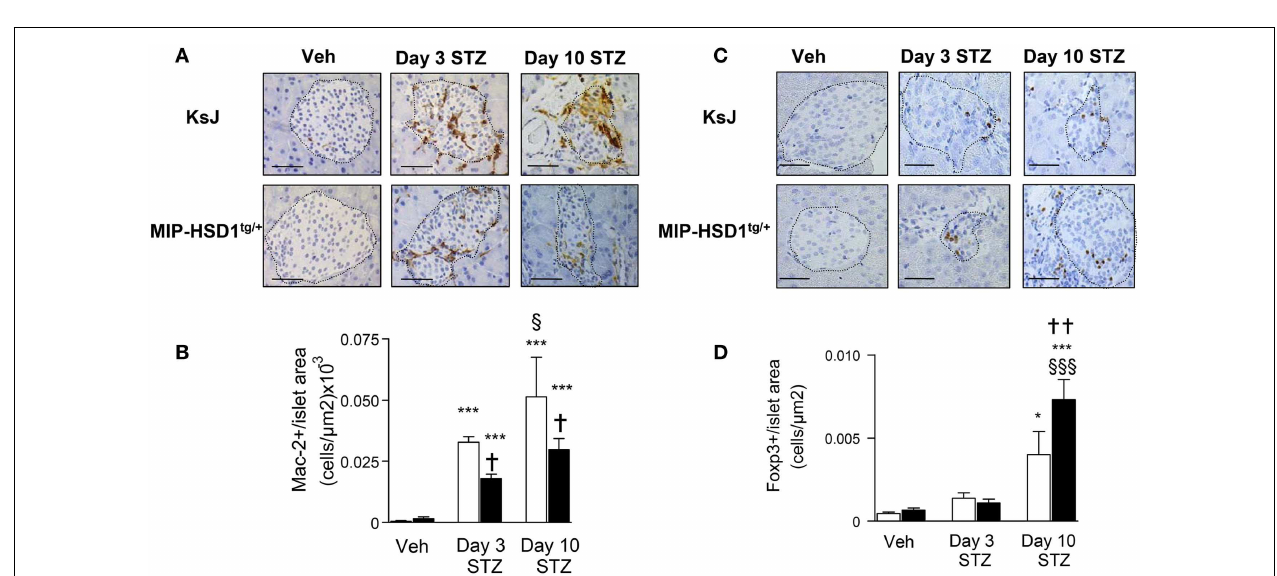
FIGURE 2 | MIP-HSD1 tg/ + mice exhibit enhanced β -cell survival and maintained replicative capacity after STZ treatment . (A) Representative immunofluorescence images of paraffin-fixed pancreata co-stained with rabbit anti-Ki67 (green), rabbit anti-PDX1 (red), and DAPI (blue) from KsJ littermate (upper row), MIP-HSD1 tg/ + (lower row) mice after vehicle treatment (Veh, left lane), 3 (middle lane) and 10days post-STZ treatment (right lane). Arrows indicate double-positive stained cells, magnification × 400. (B) PDX1